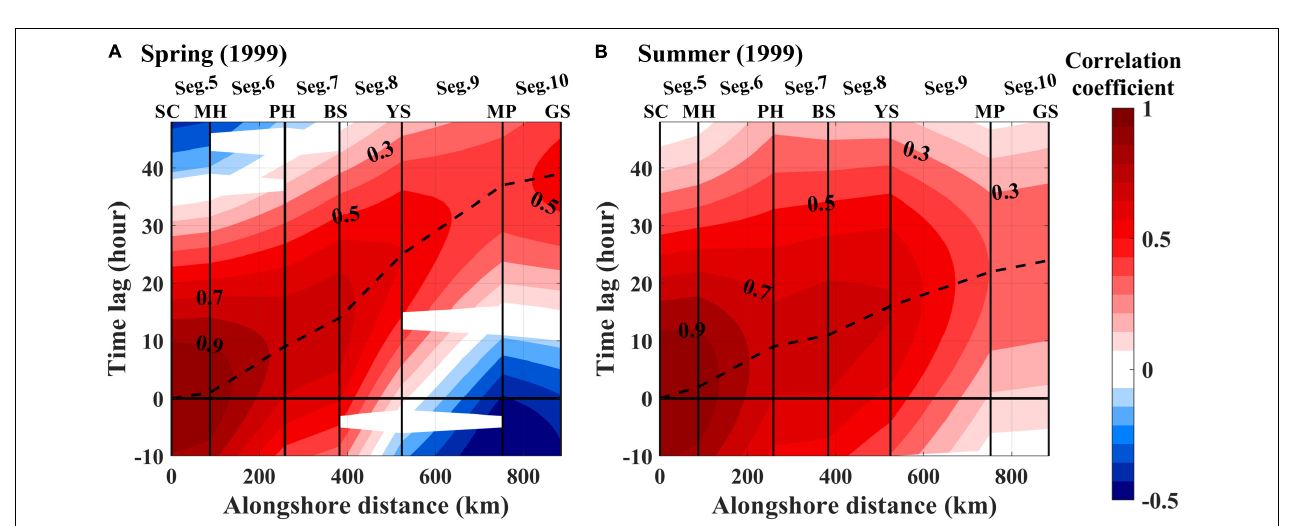
FIGURE 4 | Cross-correlation coefficients (colors with label interval of 0.2) between η adj at SC and those at seven TG stations along the coast around the KP for the (A) spring and (B) summer of 1999. Here, the x - and y -axis denote alongshore distance in km from SC toward GS and the time lag in hours, respectively. Corresponding segments and TG stations are denoted with labels on the top x -axis and vertical grid lines. The time lags at the maximum correlation are tracked and shown with dashed lines. The correlation coefficients not statistically significant at the 95% confidence level were discarded (blanked).